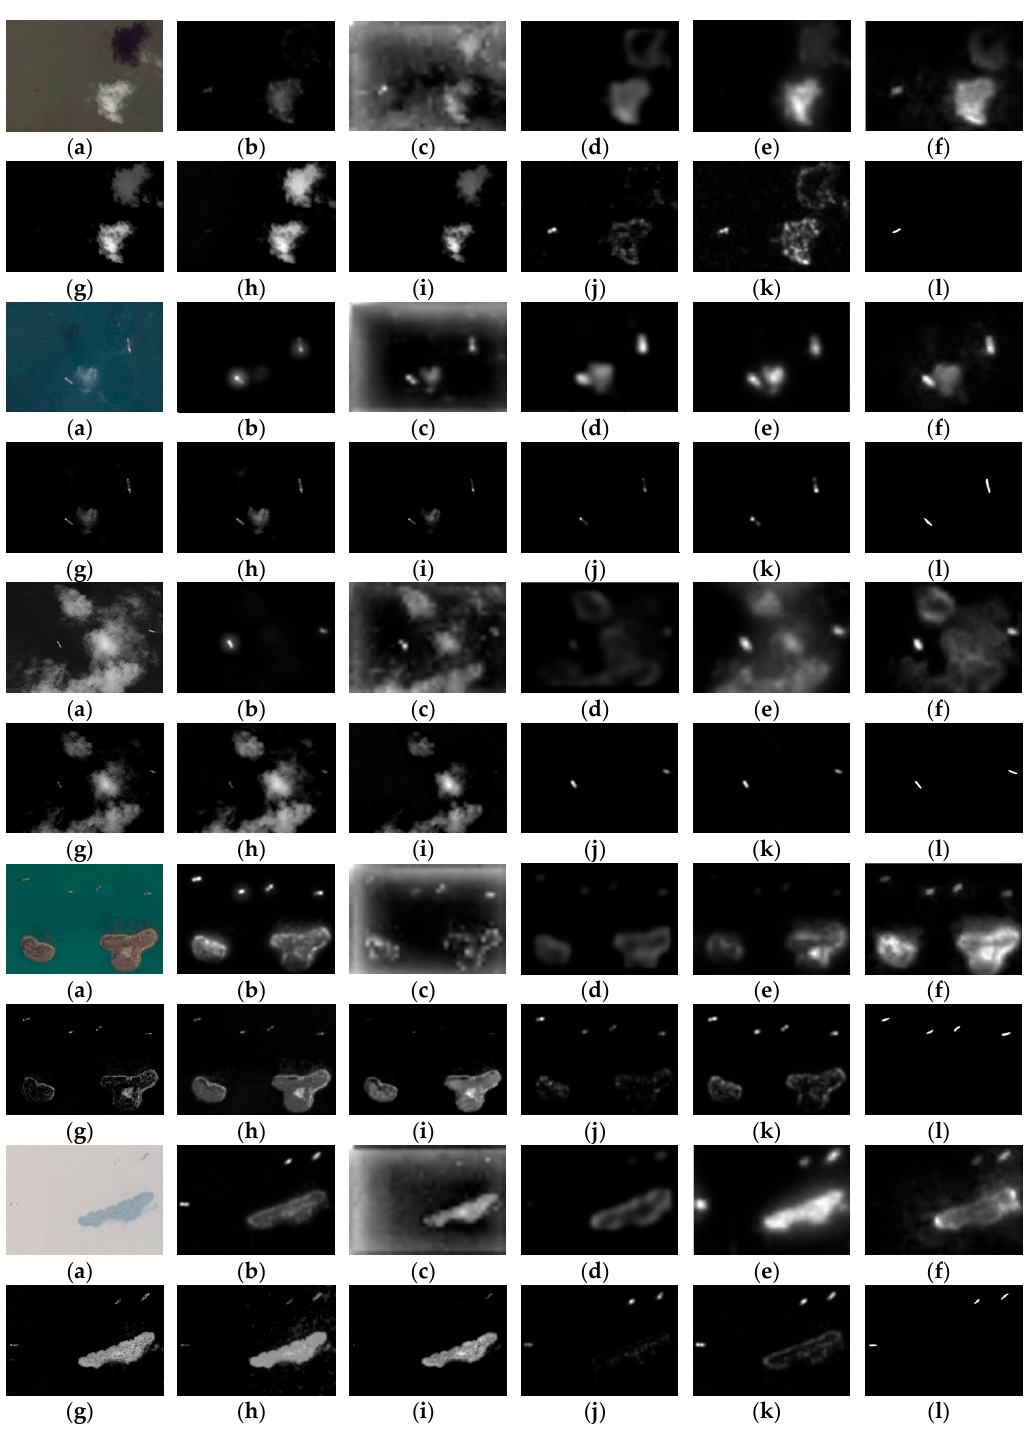
Figure 11. Visual comparison of saliency maps: ( a ) input image; ( b ) CSM; ( c ) ITTI (devised by Itti et Figure 12. Visual comparison of saliency maps: ( a ) input image; ( b ) CSM; ( c ) ITTI; ( d ) AIM; ( e ) GBVS; al.); ( d ) Attention based on Information Maximization (AIM); ( e ) Graph-Based Visual Saliency ( f ) Goferman; ( g ) LC; ( h ) HC; ( i ) FT; ( j ) SR; ( k ) PQFT; ( l ) (GBVS); ( f ) Goferman; ( g ) Linear contrast (LC); ( h ) Histogram Contrast (HC); ( i ) Frequency-Tuned Saliency (FT); ( j ) Spectral Residual (SR); ( k ) PQFT; ( l ) ground-truth.